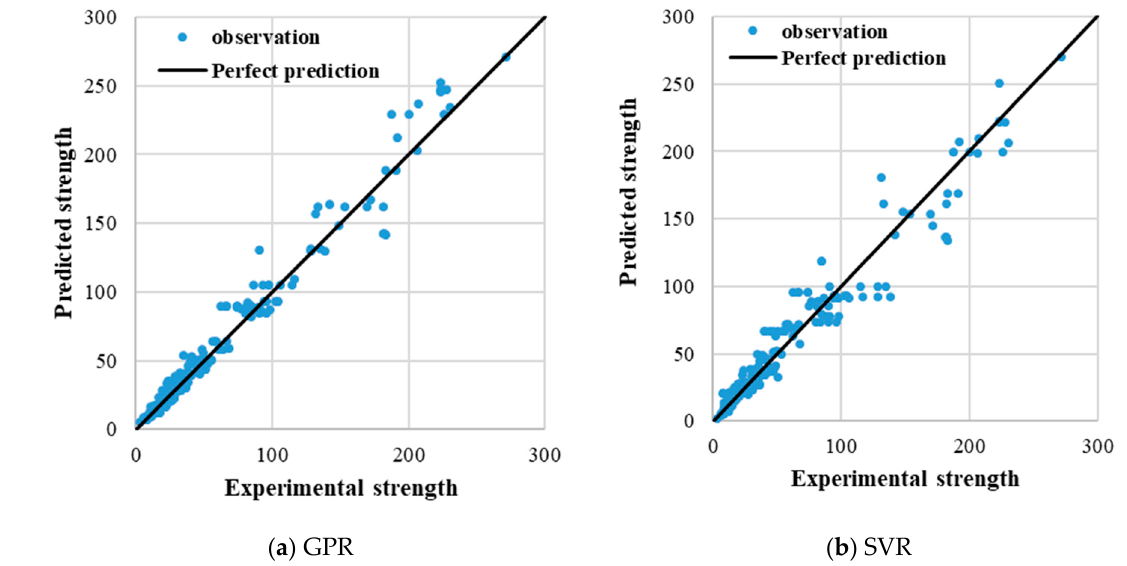
Figure 5. Plot of predicted strength (kN) against experimentally observed strength (kN) using the testing datasets. ( a ) GPR; ( b ) SVR.